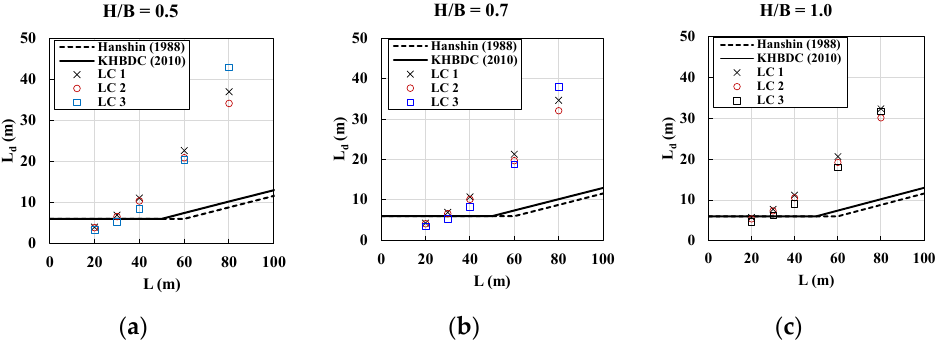
Figure 15. Comparisons between the design intermediate diaphragm spacing in the design codes and minimum required intermediate diaphragm spacing for different spans and load combinations at the 10% normal stress ratio. ( a ) 𝐻/𝐵 = 0.5 , ( b ) 𝐻/𝐵 = 0.7 , and ( c ) 𝐻/𝐵 = 1.0 . Table 3. Minimum requirements of the diaphragm spacing for different load combinations (unit: m).